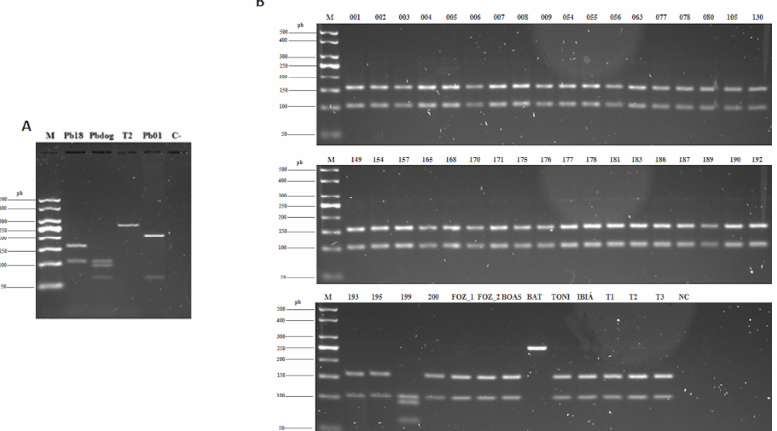
Figure 1. Patterns of fragments obtained after digestion with endonucleases Bcl I and Msp I (PCR-RFLP